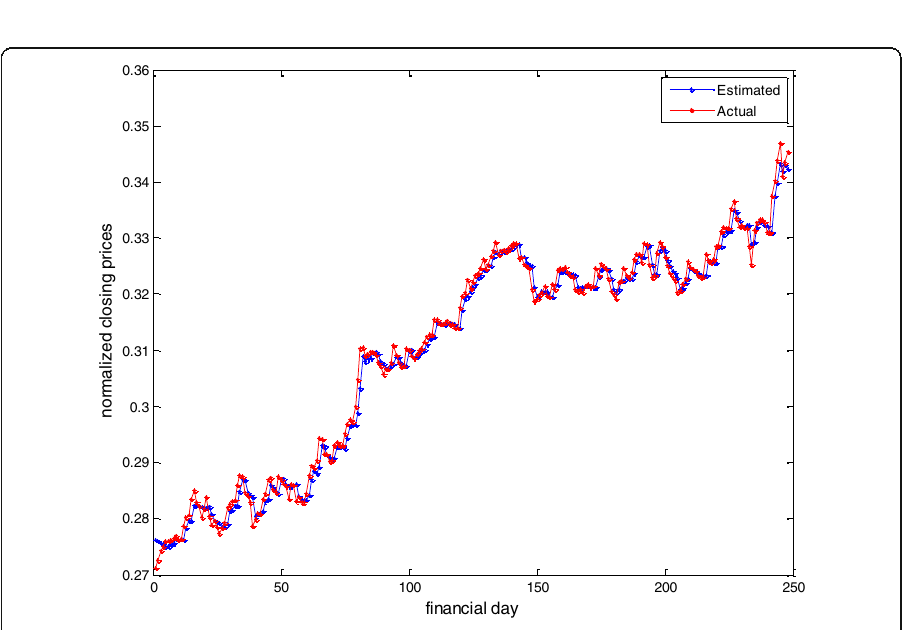
Fig. 6 Actual v/s estimated closing prices by CPNN-GA for BSE indices